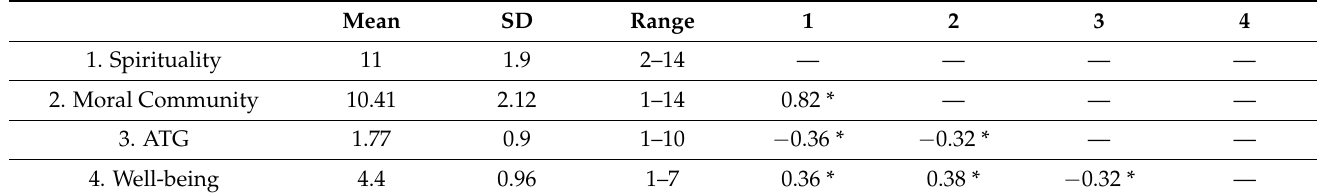
Table 1. Means, standard deviations, and correlations.